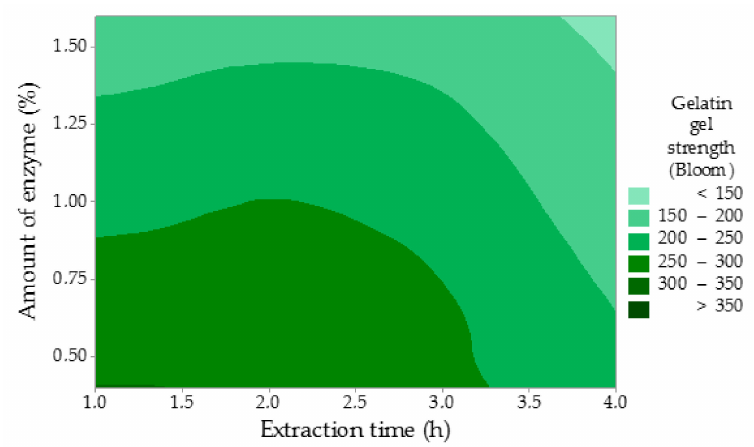
Figure 3. The influence of the time of extraction and the amount of the enzyme on the gelatin strength.